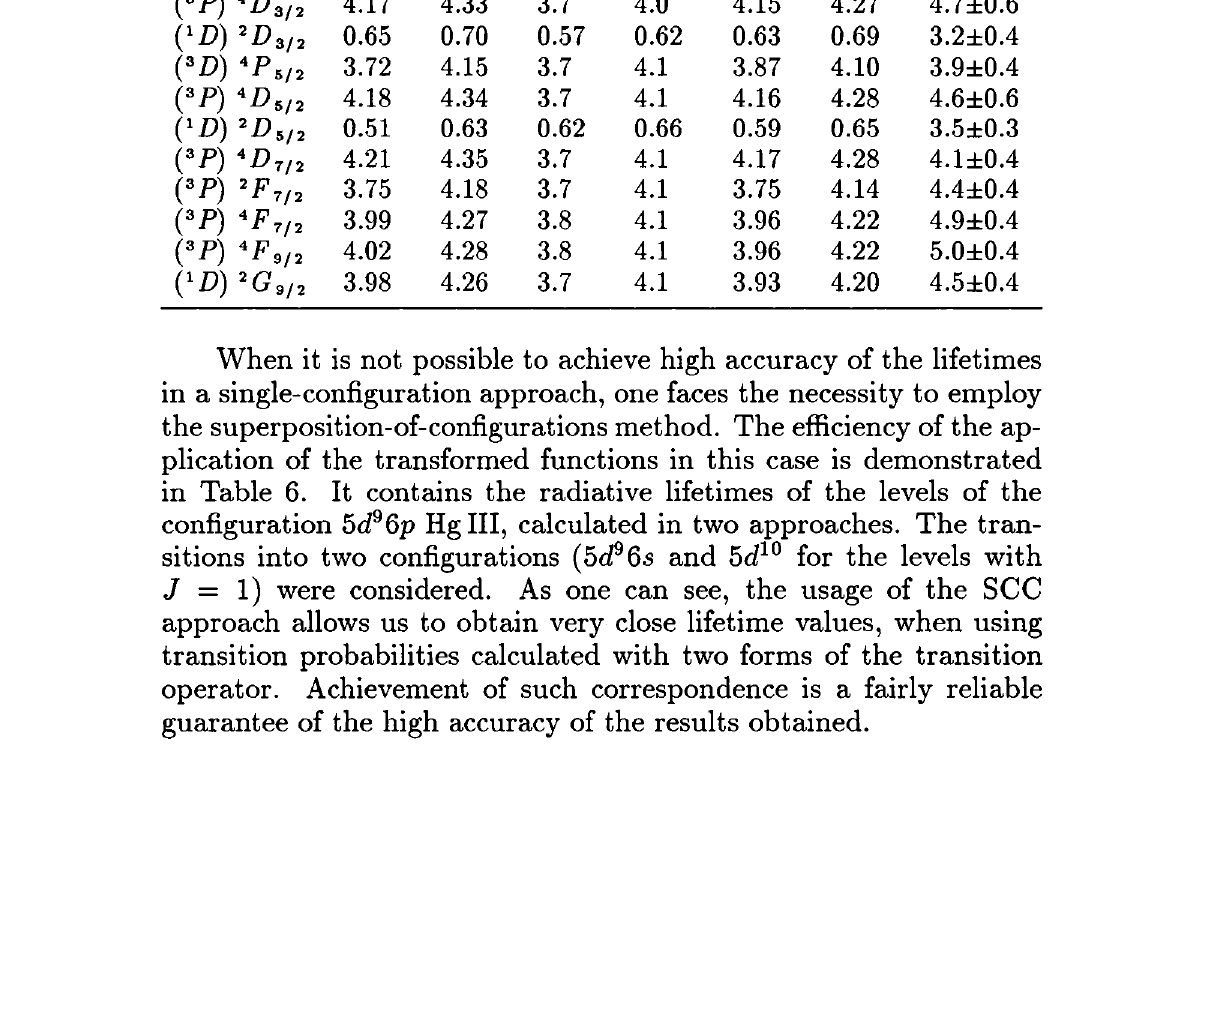
Table 5. Radiative lifetimes (ns) of the levels of the configuration 3p 4 3d Ar II Successive Simplified (L So) LSJ a b 0